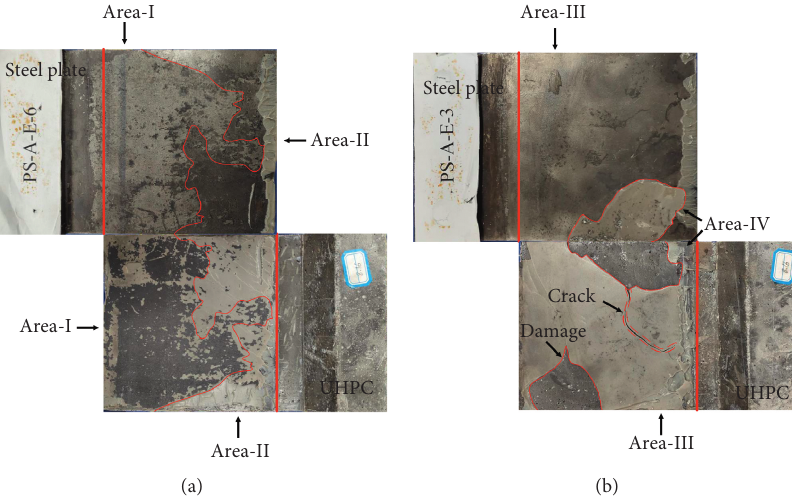
Figure 3: Interface failure mode of specimen PS-E. (a) Epoxy-steel interface failure (E-S interface failure) and epoxy-UHPC interface failure (E-U interface failure). (b) Epoxy-steel interface failure (E-S interface failure), epoxy-UHPC interface failure(E-U interface failure), and epoxy layer’s localized